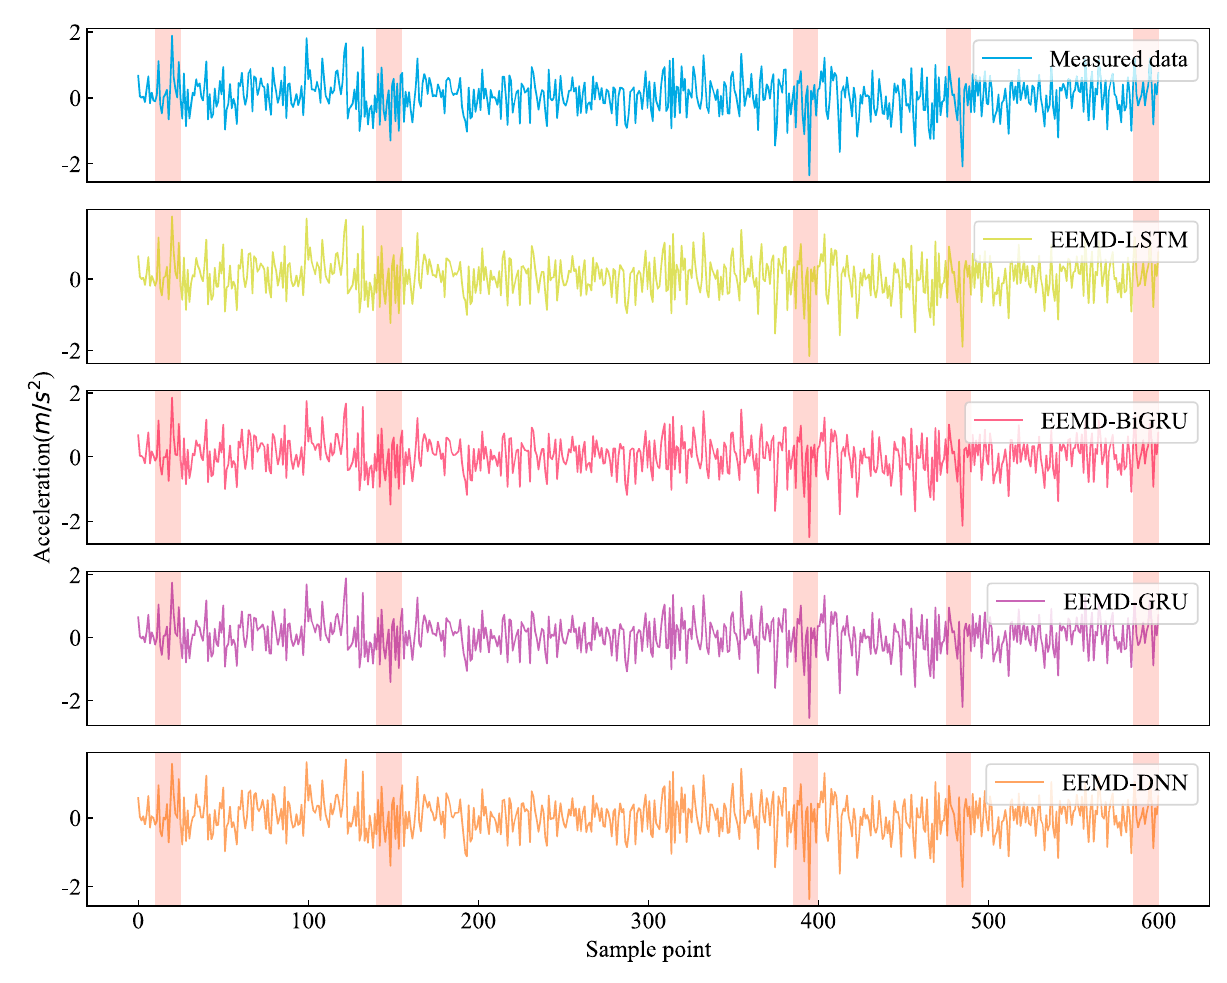
Figure 12. Comparison of the imputations with the four EEMD-based models.